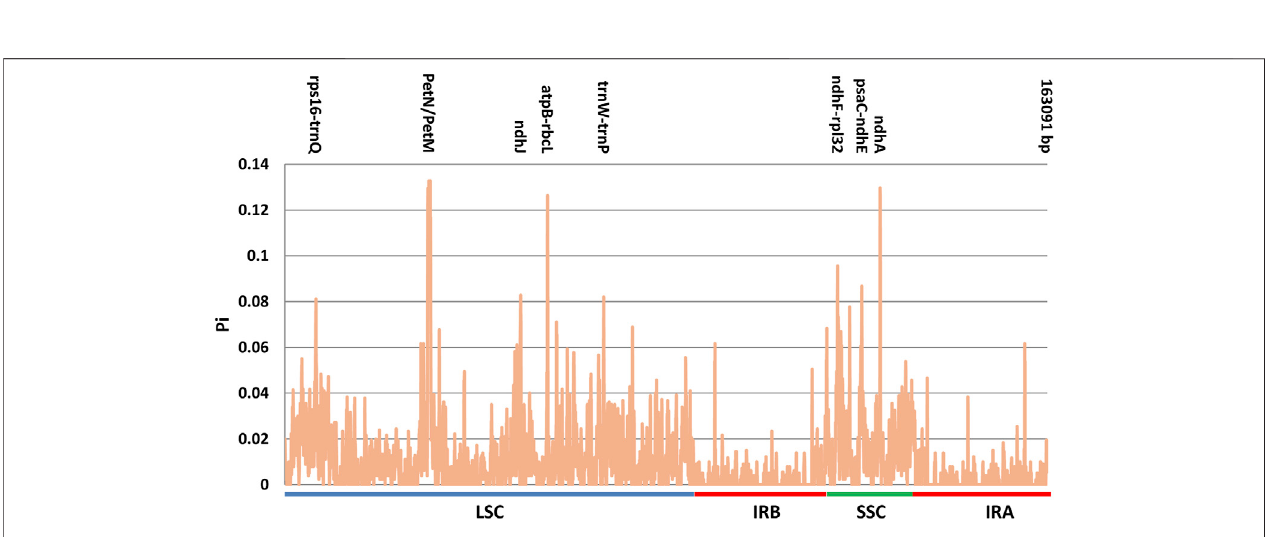
FIGURE 8 | Nucleotide diversity (Pi) values among the nine cp genomes.